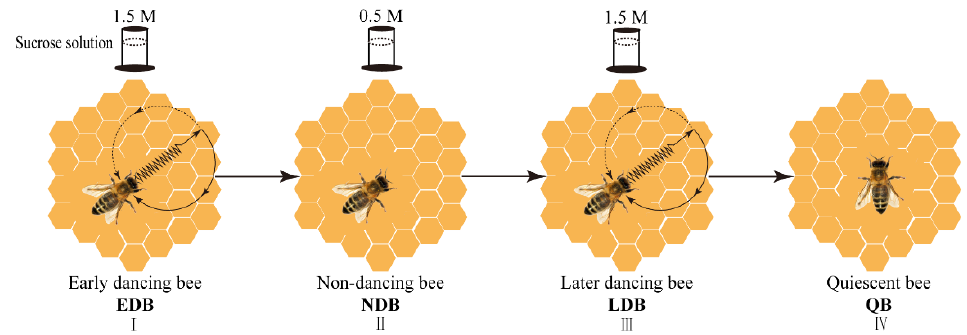
Figure 1. The diagram of the experimental procedure. By varying the concentration of sucrose solution in the feeder (1.5 M → 0.5 M → 1.5 M) that is located 200 m from the observation hive, the occurrence of the waggle dance could be manipulated, that is, foragers performed waggling dance, non-dancing and waggling dance again. After the feeder was removed for 1 h, the honey bees that kept a quiescent state were sampled. Note: EDB referred to the waggling dancers after foraging on a feeder with 1.5 M sucrose solution ( I ). NDB referred to the non-dancing bees after foraging on another feeder with 0.5 M sucrose solution replacing the feeder with 1.5 M sucrose solution ( II ). LDB referred to the waggling dancers after foraging on the feeder with 1.5 M sucrose solution replacing the feeder with 0.5 M sucrose solution ( Ⅲ ). QB referred to quiescent bees on the comb after removing the feeder for 1 h ( IV ).